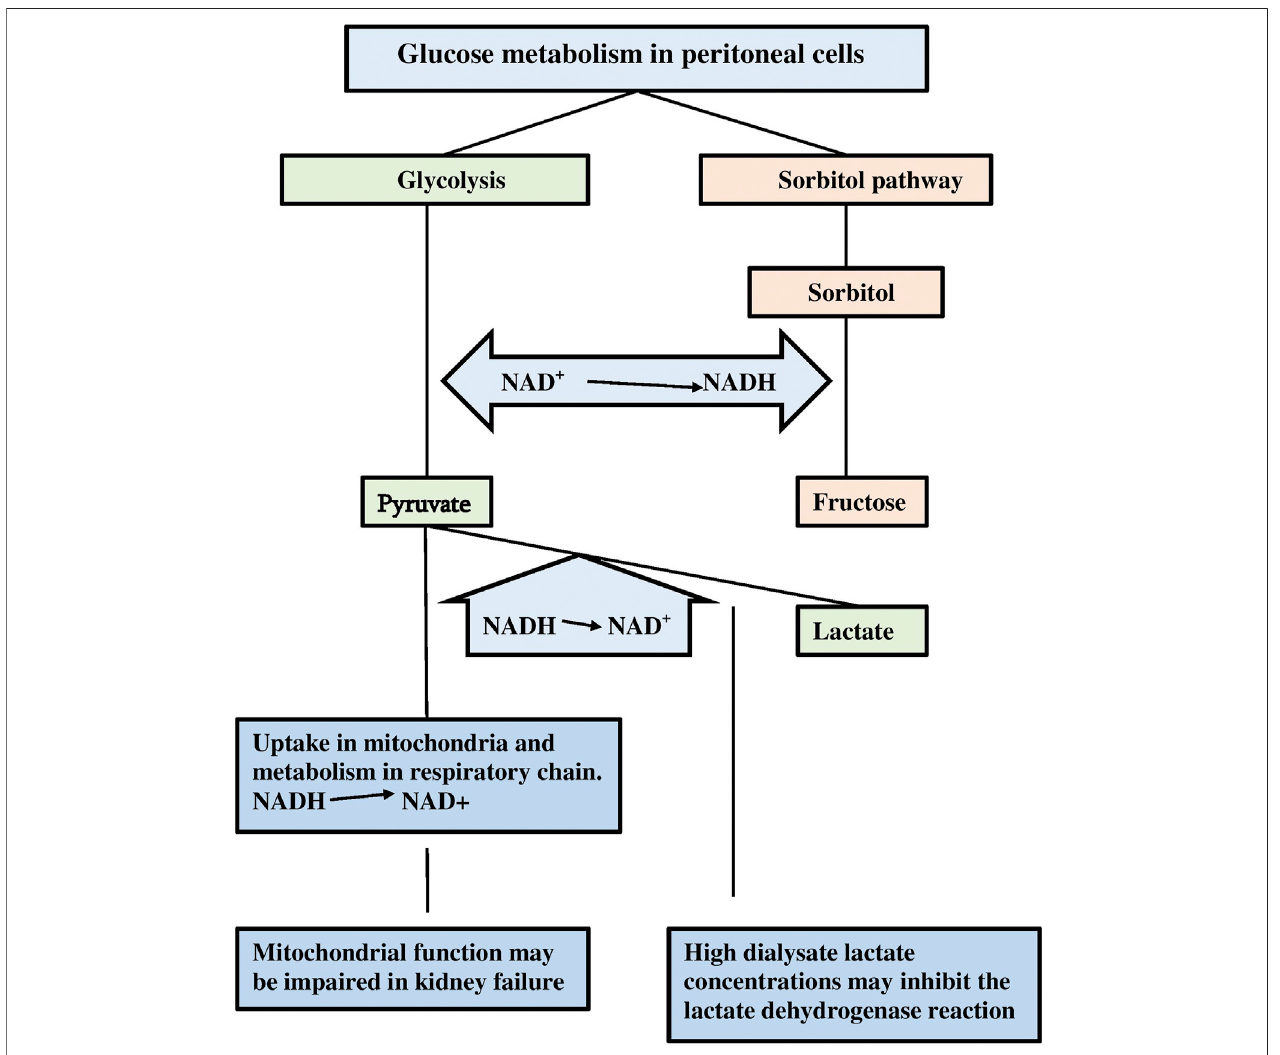
FIGURE 2 | A scheme of the intracellular glucose metabolism in case of a large supply. Note the formation of NADH during the glycolysis and the sorbitol/polyol pathway, and the possible inhibition of compensatory NAD + back gain due to inhibition of lactate dehydrogenase and mitochondrial dysfunction.